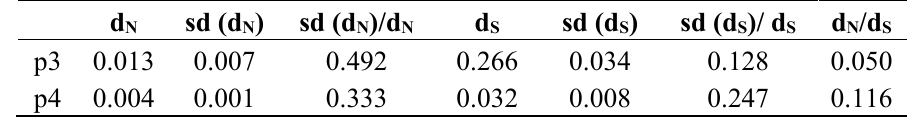
Table 3. Synonymous and non-synonymous substitution rates of p3 and p4 coding region of European mountain ash ringspot-associated